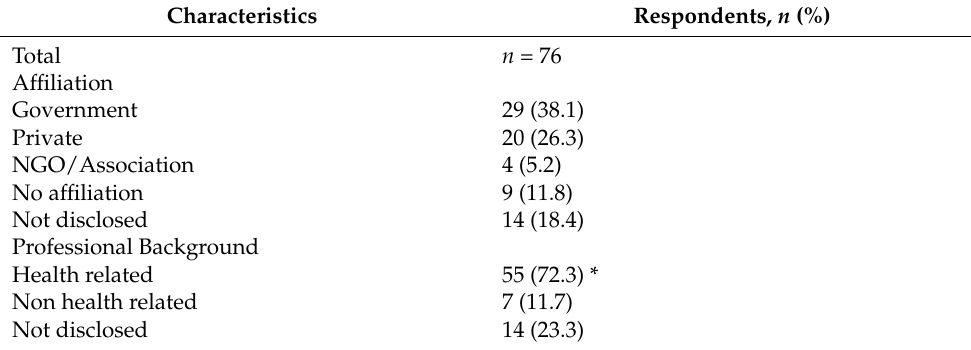
Table 1. Respondents’ characteristics ( n = 76).